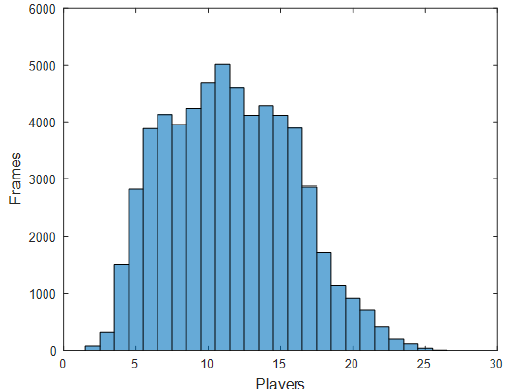
Figure 10. Distribution of number of players per frames. Table 2. Number of detected players per frame.